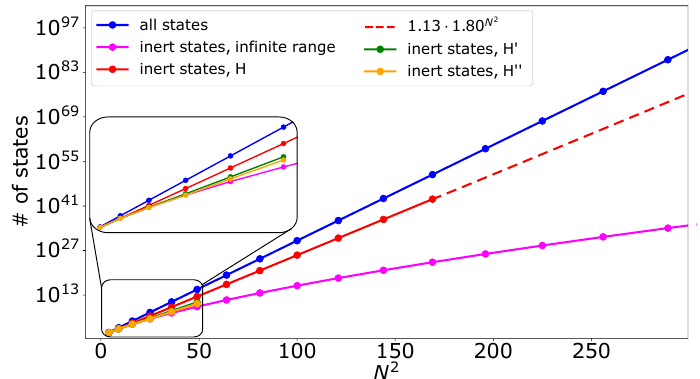
Figure 4: The number of inert states on N × N lattices for different ranges of rectan- gular interactions: (red) ˆ H , (green) ˆ H ′ , (yellow) ˆ H ′′ , (pink) infinite range (rectan- gles of any size), and, for comparison, (blue) the full dimensionality of the Hilbert space: 2 N 2 . Red curve scales as 1.13 · 1.80 N 2 (a straight line on the log plot). Green and yellow curves have slight deviations from straight lines. However, due to the limited number of data points, it is hard to tell if they grow exponentially or sub- exponentially. For the system with no Hilbert space fragmentation (i.e., infinite range rectangular interactions) the number of inert states grows sub-exponentially (pink). An analytic expression for the pink curve was obtained using results from Ref. [ 68 ] .